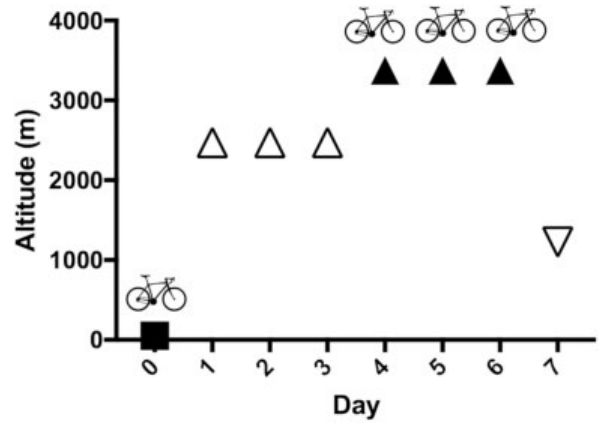
Fig. 1 Schematic representation of the study set-up. Participants performed an exercise test on four occasions: one time at 50m altitude (normoxic exercise), and three times on 3 consecutive days at 3,375m altitude (hypoxic exercise). Before the hypoxic exercise tests, participants acclimatizedtothealtitudefor3 daysat 2,475m altitude. After thelasthypoxicexercisetest, participantsdescendedto 1,225m